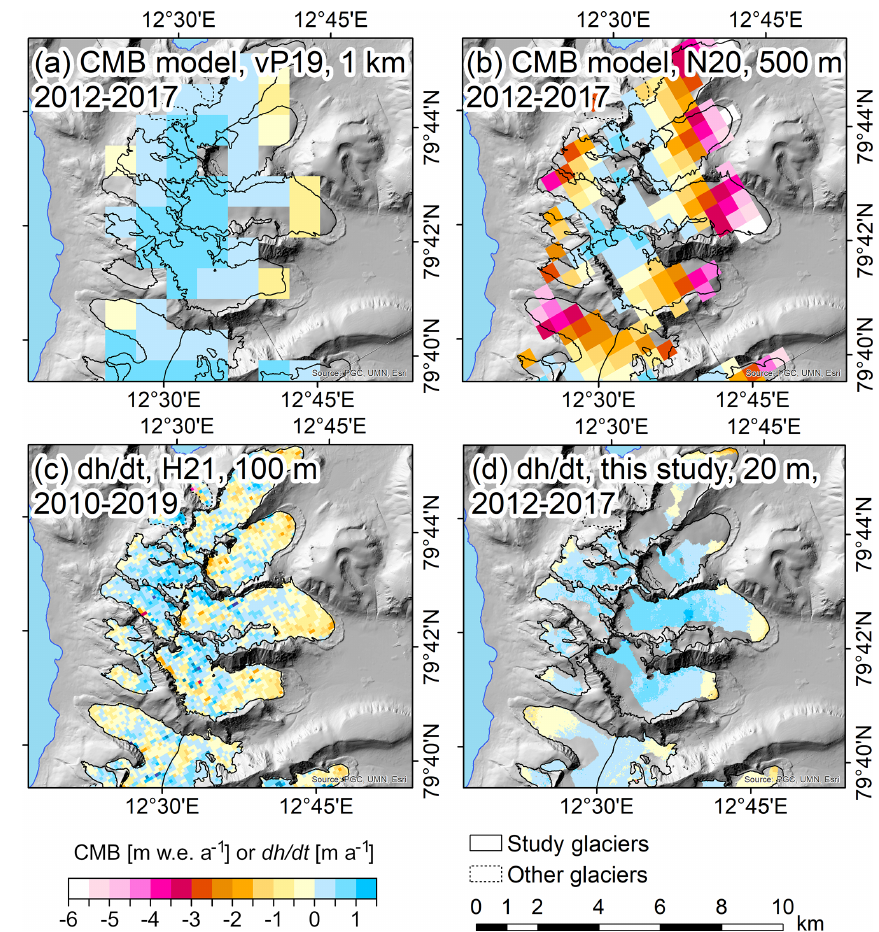
Figure 7. Example comparison of glacier mass balance models and elevation change observations at Site 16 in SV-N. Outcomes of climatic mass balance (CMB) models by (a) van Pelt et al. (2019) at 1000m resolution and by (b) Noël et al. (2020) at 500m resolution. Observed d h/ d t based on (c) Hugonnet et al. (2021) at 100m resolution and (d) this study at 20m resolution, downsampled from 2m. Note the colour scale is common for CMB and d h/ d t . Hillshaded background: ArcticDEM; source: Polar Geospatial Center, University of Minnesota, and